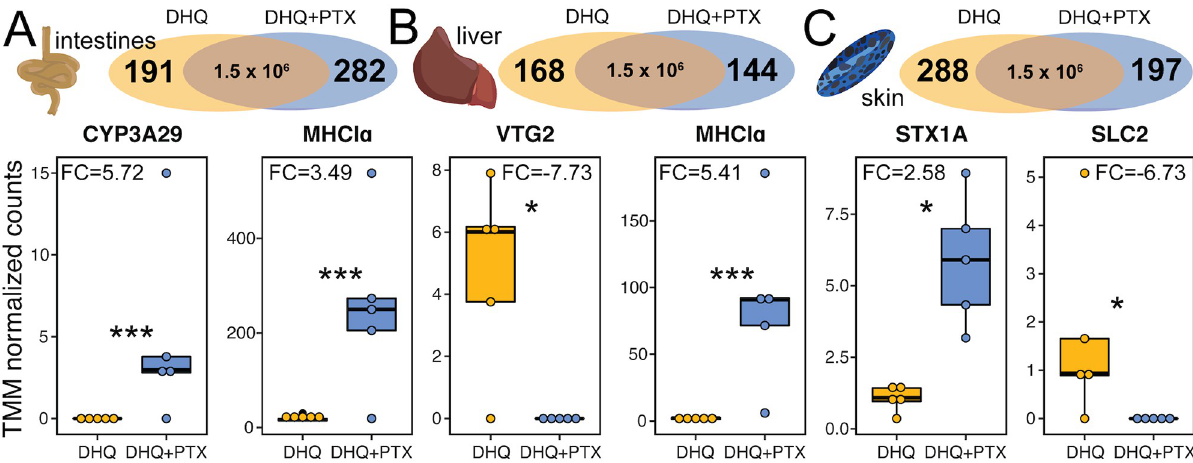
Fig 2. Differentially expressed genes in different tissues. Boxplots show TMM normalized expression levels in the DHQ-fed group (yellow) and DHQ +PTX fed group (blue) for a subset of differentially expressed genes. (A) Differentially expressed genes in the intestines include Cytochrome P450 Family 3 Protein 29 (CYP3A29) and MHC Class I alpha (MHCI α ). (B) Differentially expressed genes in the liver include vitellogenin 2 (VTG2) and MHCI α . (C) Differentially expressed genes in the skin include syntaxin 1A (STX1A) and solute carrier family 2 (SLC2). (FC indicates log2 fold change values, � indicates adjusted p-value < 0.05, ��� indicates adjusted p-value < 0.005; y -axes of individual plots have different scales).